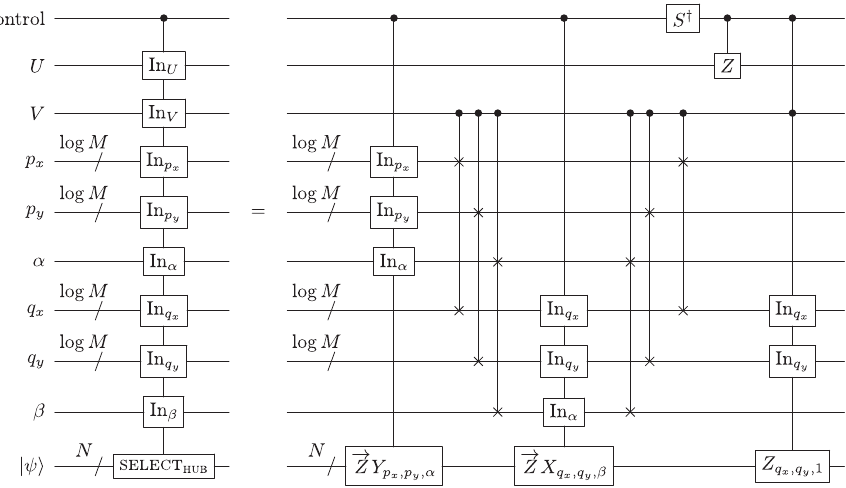
FIG. 19. A SELECT circuit for the Hubbard model, with function determined by how p relates to q . Recall from Eq. (45) that ffiffiffiffiffiffiffiffiffi p M ¼ N= 2 for the Hubbard model. This circuit has a T count of 10 N þ O ð log N Þ and spans N þ 3 log N þ O ð 1 Þ qubits. If control is OFF , the circuit has no effect. Otherwise, if j U ij V i ¼ j 1 ij 0 i , it will be the case that ð p; α Þ ¼ ð q; β Þ , and our circuit applies − Z p; α . If